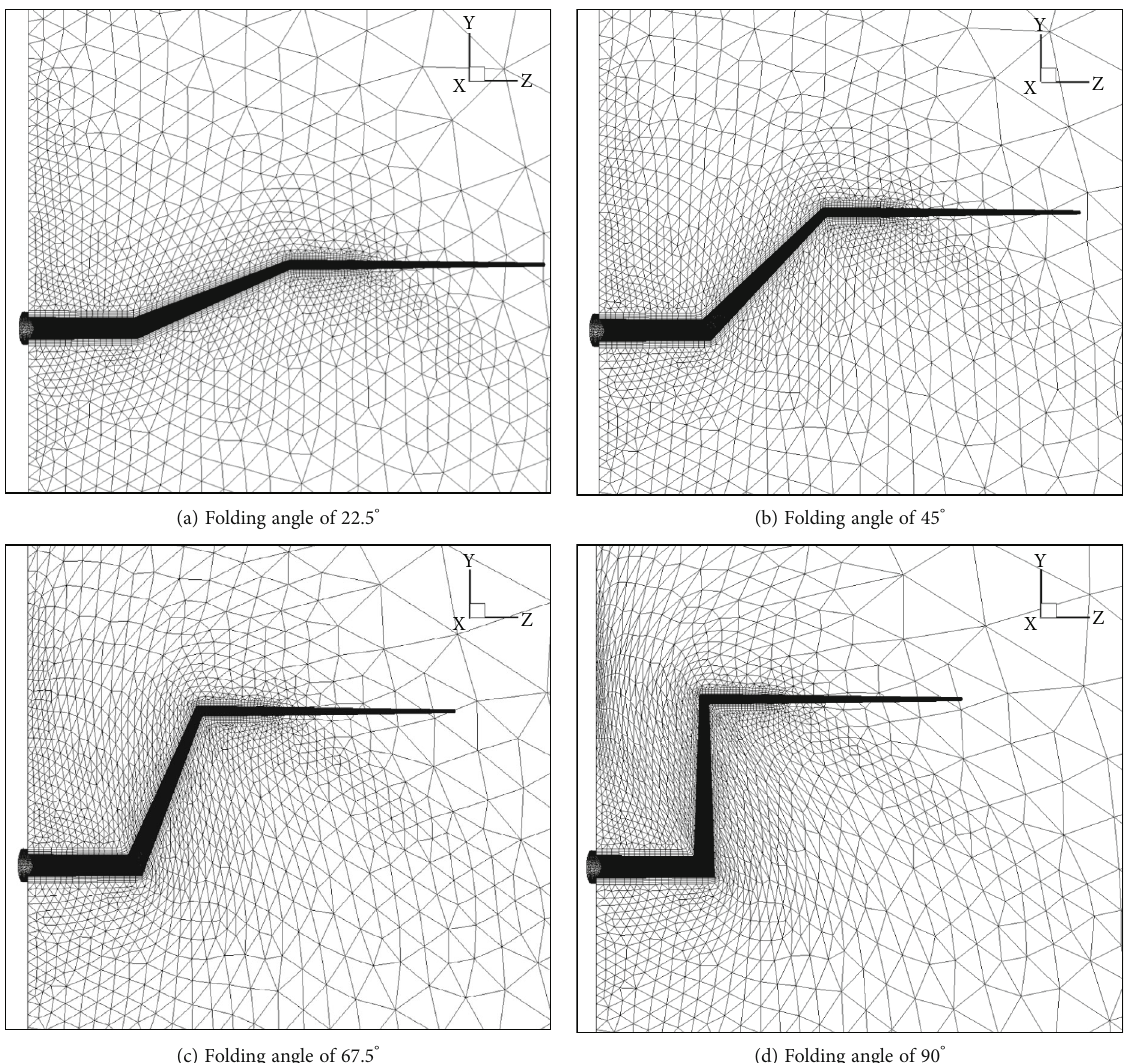
Figure 4: Internal mesh of intermediate con fi gurations.